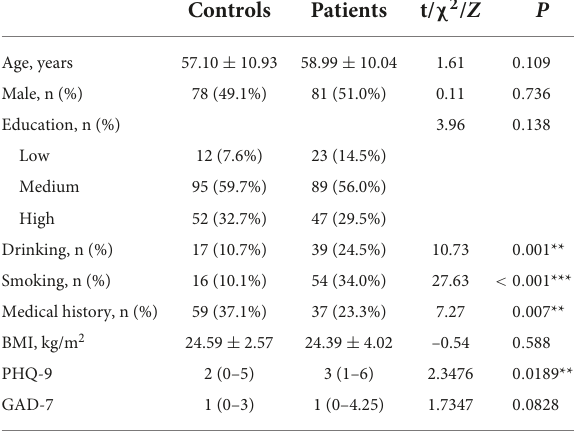
TABLE 1 Demographic data and clinical characteristics of MM patients and control subjects.